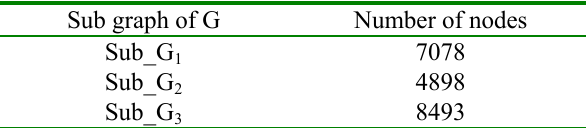
Table 3. Number of nodes in each sub graph Sub graph of G